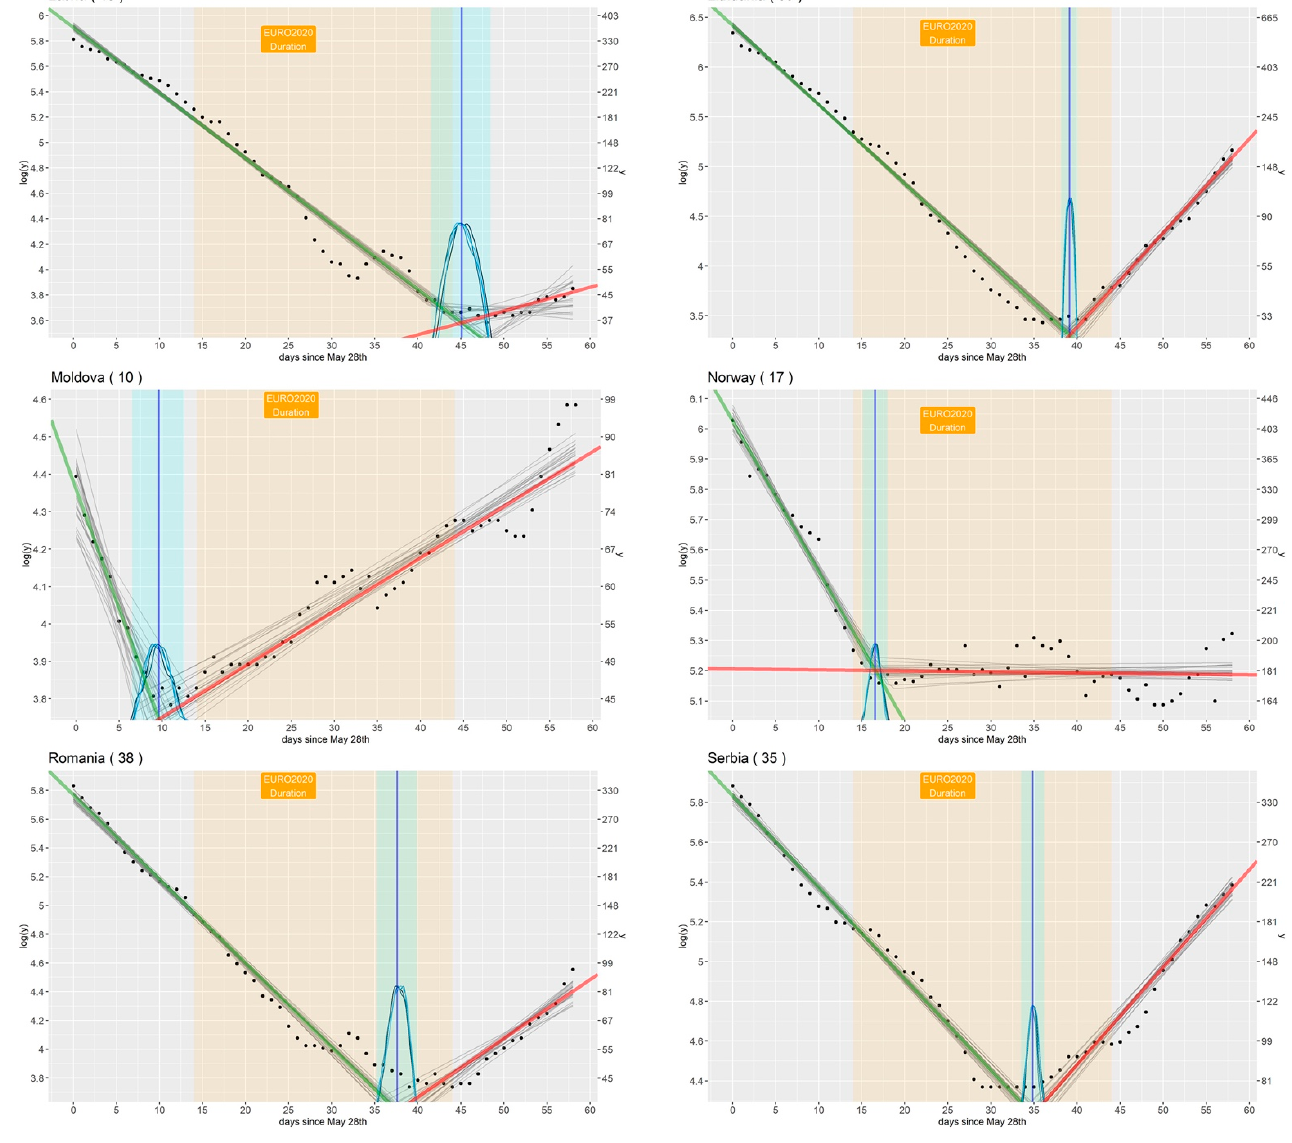
Figure 5. Latvia, Lithuania, Moldova, Norway, Romania, and Serbia not participating countries. Yellow space: duration of the tournament. Red vertical line: first match. Purple vertical line: last match. Green vertical line: last hosted match. Blue vertical line: changepoint. Blue space: CI amplitude for the changepoint. Green segment: case rate trend before the changepoint. Red segment: case rate trend after the changepoint. Blue bell-shaped peaks, grey segments, black dots, and rightmost and leftmost y axis: same as in previous figures.